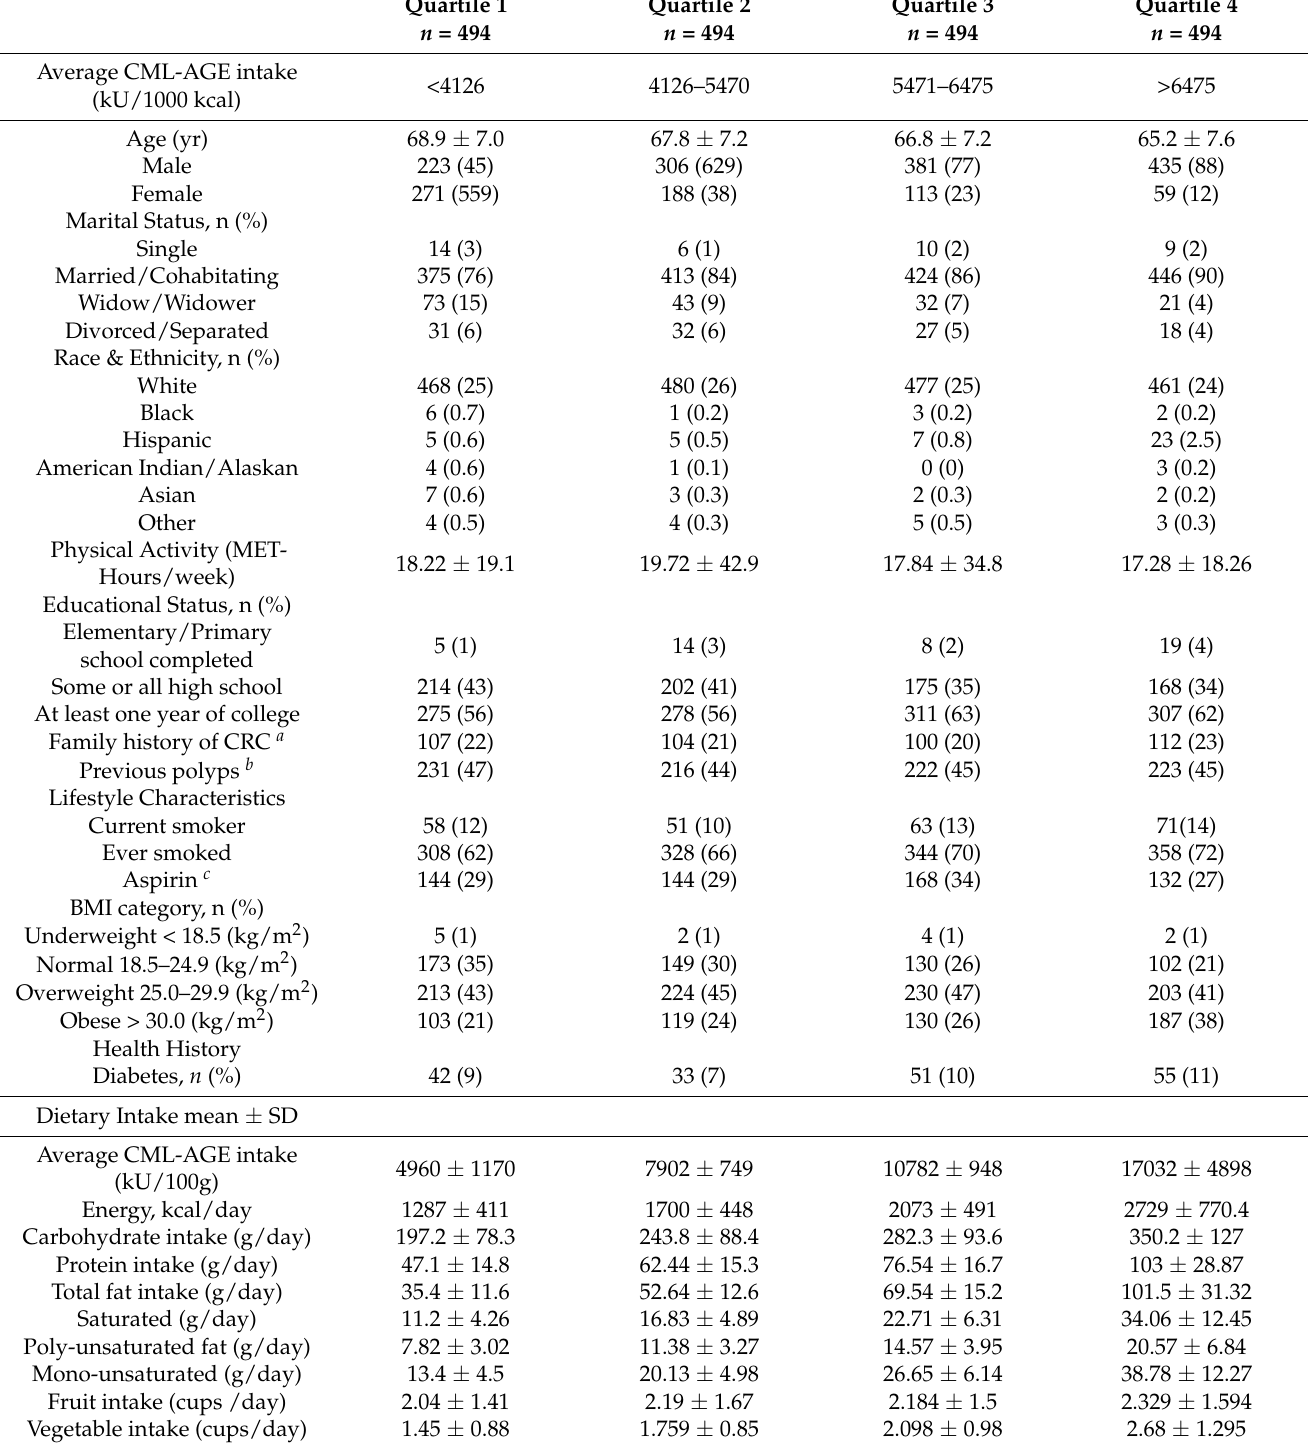
Table 1. Baseline characteristics of pooled sample by quartiles of CML-AGE (kU/1000 kcal)